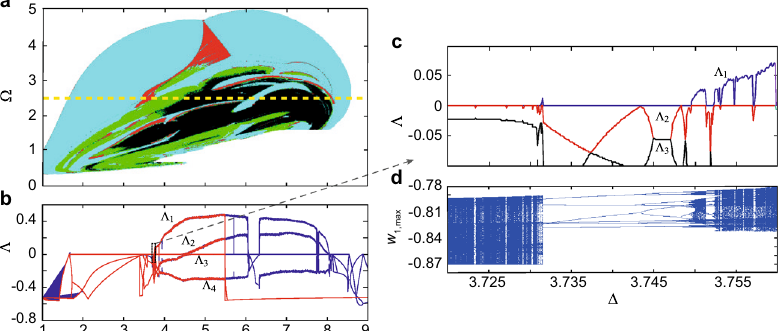
Fig. 2 Hyperchaos in a ring of fi ve qubits. a Map showing areas of ( Δ , Ω ) space corresponding to different regimes of long-term behavior for a ring of fi ve qubits. Black denotes areas of hyperchaos with two positive Lyapunov exponents, green is a region of chaos with one positive Lyapunov exponent, cyan is a periodic regime, red areas correspond to quasiperiodic behavior, and white is a steady-state regime. b Variation of the four largest Lyapunov exponents with Δ ; blue dots correspond to Δ increasing from 1 to 9, red dots to Δ decreasing down to 1. c A zoom of the region of b within the black rectangle. d Single-parametric bifurcation diagram corresponding to c , in which the vertical positions of each point correspond to the local maxima of w 1 ( t ). For all fi gures Ω =